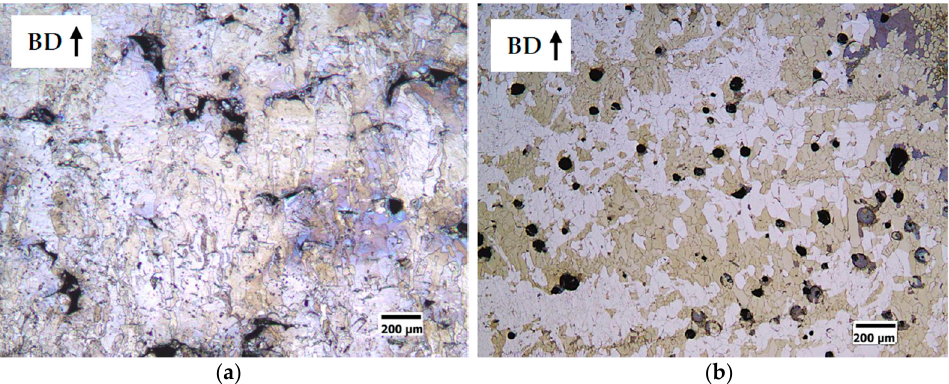
Figure 10. Example of non-columnar microstructure in the high porosity samples. ( a ) S1-FeSi3 ( E = 150 Jm − 1 , v = 0.5 ms − 1 , P = 75 W) and ( b ) S20-FeSi6.5 ( E = 400 Jm − 1 , v = 0.6 ms − 1 , P = 240